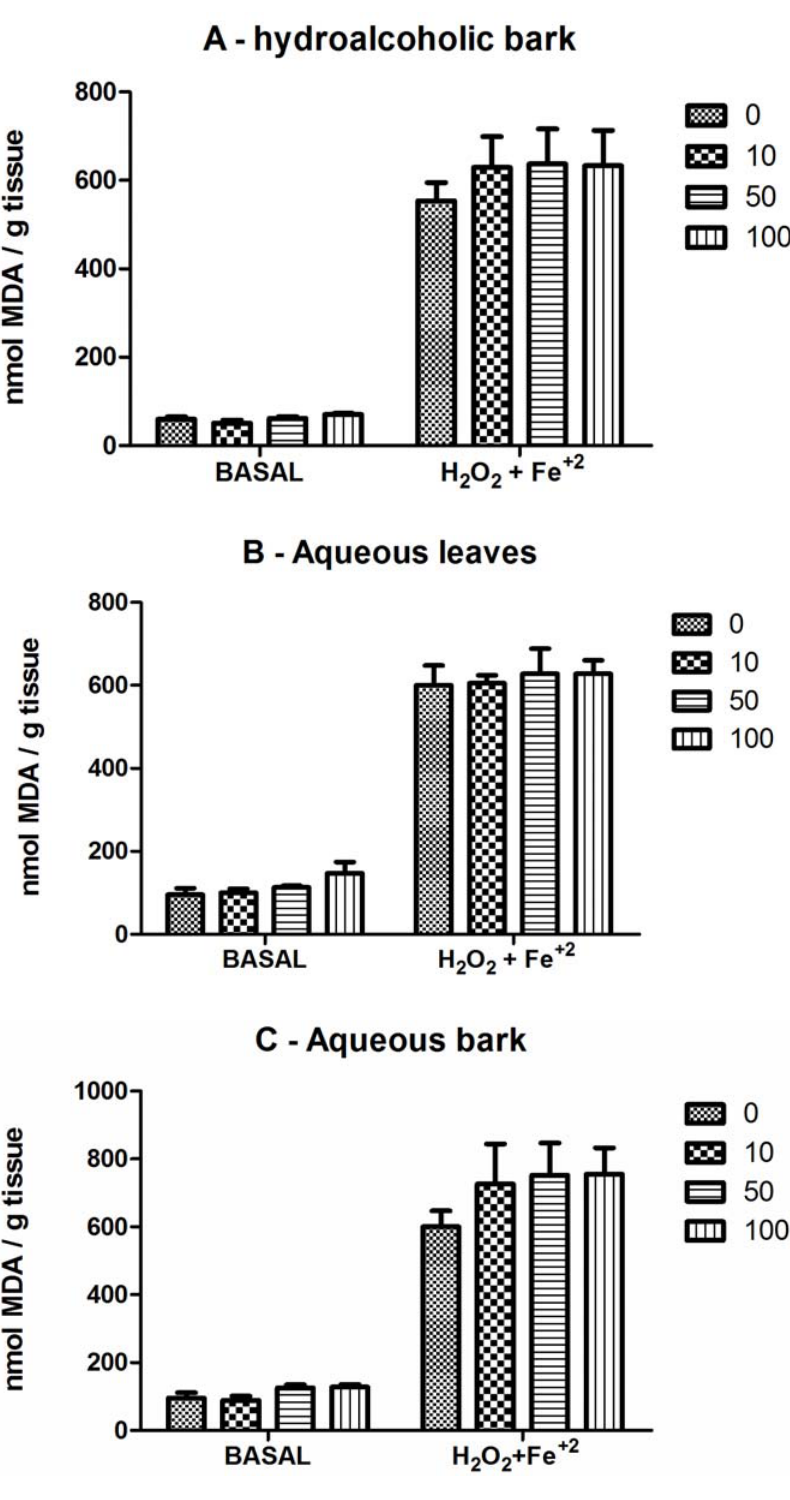
Figure 3. S. rotundifolium extracts did not inhibit Fenton’s reaction. ( A ) hydroalcoholic bark extract; ( B ) aqueous leaves extract; ( C ) aqueous bark extract on basal and Fe 2+ (10 µM) + H O (1 mM)-induced deoxyribose degradation. Deoxyribose was incubated for 2 2 20 min with or without H O or Fe 2+ + H O in the presence or absence of extracts. Data are 2 2 2 2 mean ± SEM. Values average from 3 to 4 independent experiments performed in